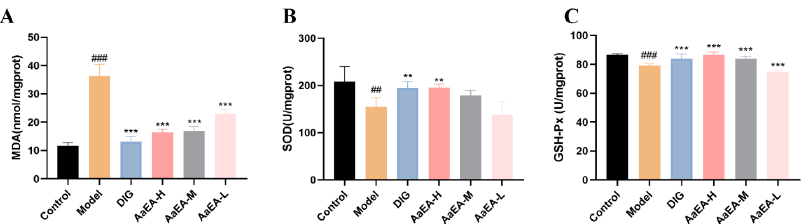
Figure 4. Effects of AaEA alleviated oxidative stress by regulating MDA level ( A ), SOD ( B ), and GSH-px activities ( C ) (n = 6). Unless indicated, no significant difference was observed between groups. Compared with control group, ## p < 0.01 and ### p < 0.001. Compared with ConA group, ** p < 0.01, and *** p < 0.001.